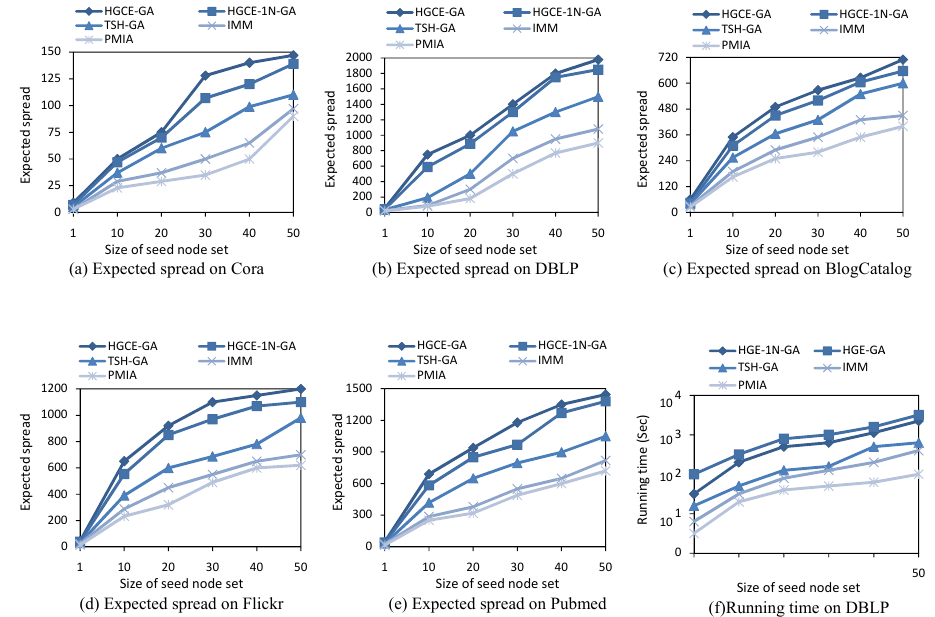
Figure 7. Expected spread and running time with different sizes of seed node set K